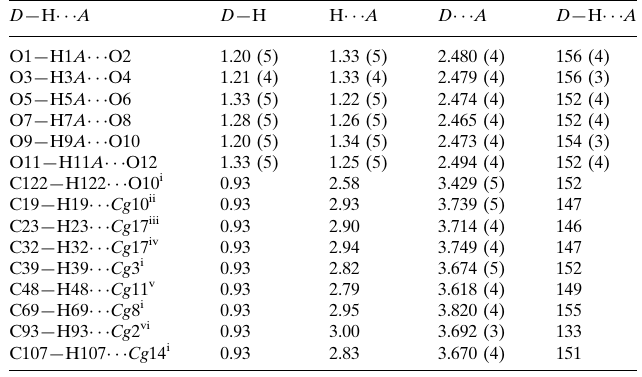
Hydrogen-bond geometry (A˚ , (cid:2) ). D —H (cid:1)(cid:1)(cid:1)